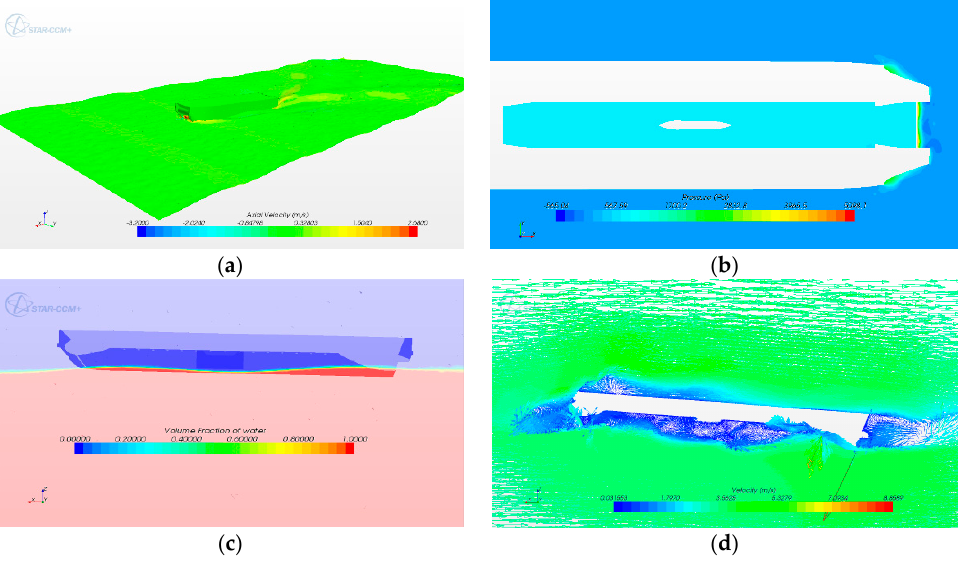
Figure 20. Numerical results of ( a ) wave evolution; ( b ) pressure distribution in water plane; ( c ) longitudinal wave pattern; ( d ) velocity distribution in the center plane.